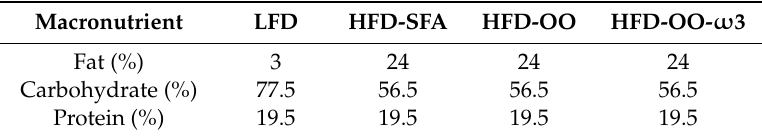
Table 1. Macronutrient composition of diets.